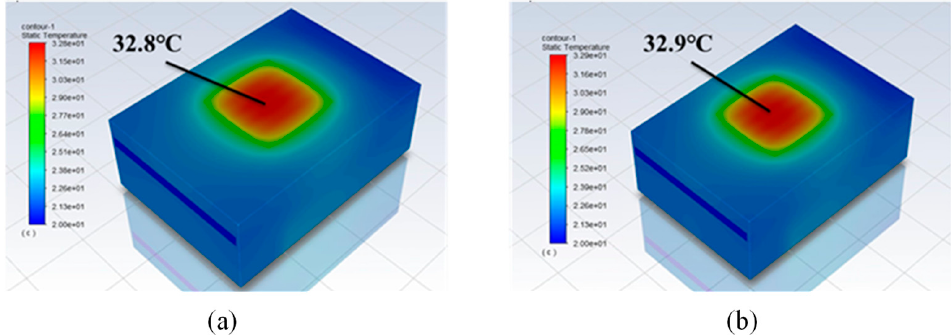
Figure 16. Temperature distribution of double-layer return microchannel heat sink under different hydraulic diameters ( a ) 0.48 mm, ( b ) 0.49 mm. Figure 15. SEM of microchannel with diameter of ( a ) 600 μ m, 500 μ m, ( b ) 400 μ m,